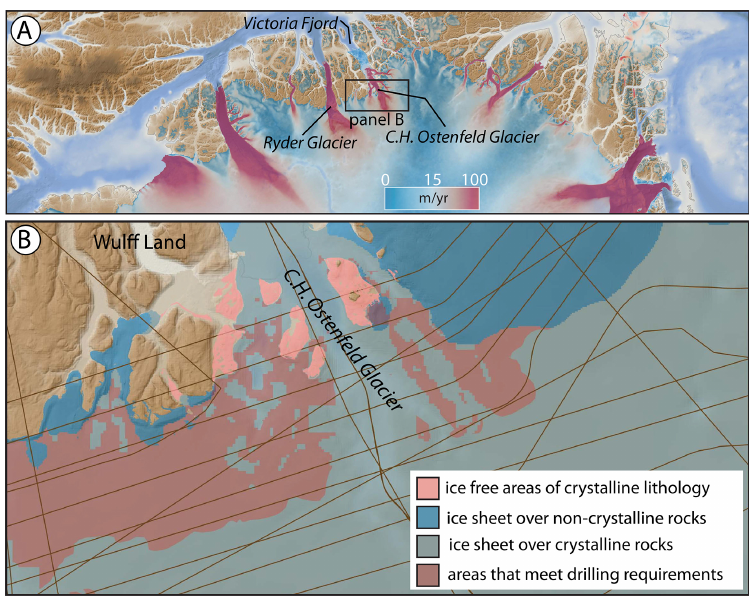
Figure 6. (a) North Greenland showing ice-sheet surface velocity; velocity from Greenland Ice Sheet velocity map from Sentinel-1, winter campaign 2019/2020 (version 1.3); QGreenland v2.0. (b) Areas that meet drilling requirements with a focus on bedrock lithology: bright blue are areas under the ice sheet with non-quartz-bearing lithologies, whereas the more muted blue colors depict our estimate of where there are quartz-bearing lithologies at the ice bed. Pink areas are quartz-bearing lithologies beyond the ice margin, and shown in muted red color are the areas that meet the drilling requirements. NASA Operation IceBridge (OIB) flight lines are shown as thin brown lines. Basemap topography and bathymetry from Morlighem et al. (2017).